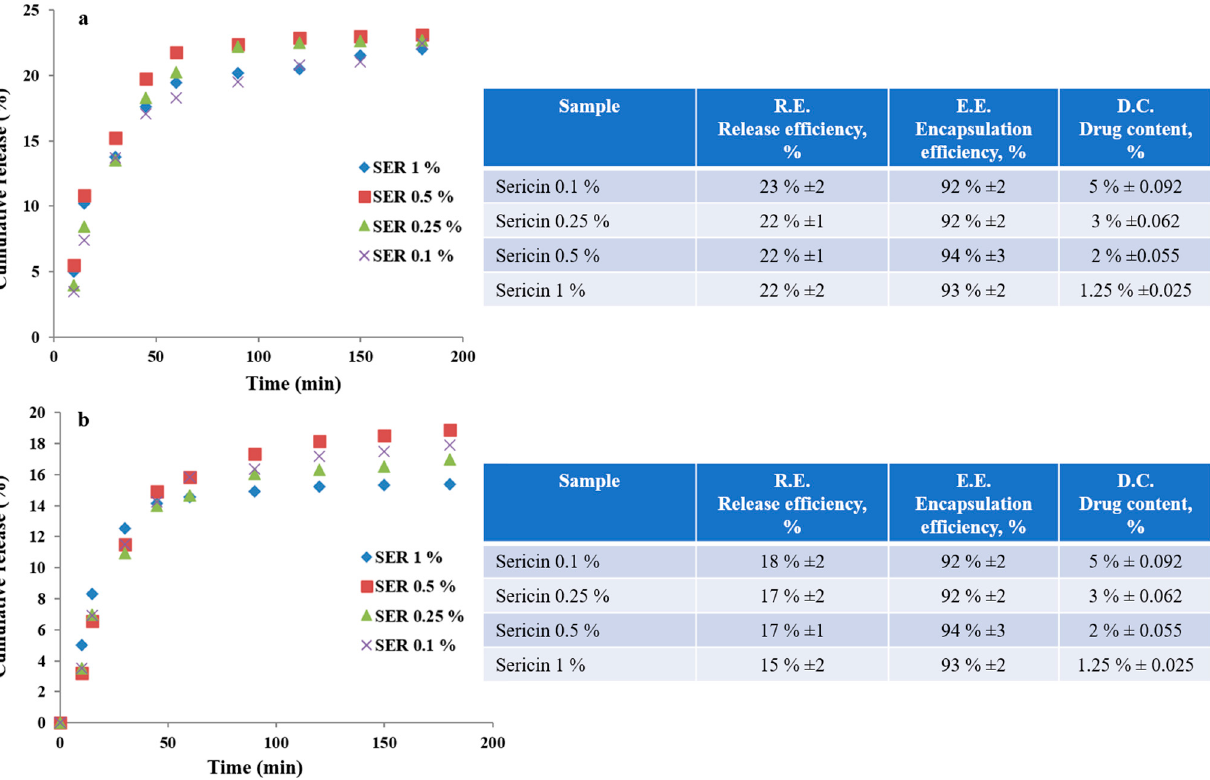
Figure 5. Doxorubicin release profiles from sericin nanoparticles in enzymatic media: protease XIV ( a ); chymotrypsin ( b ).